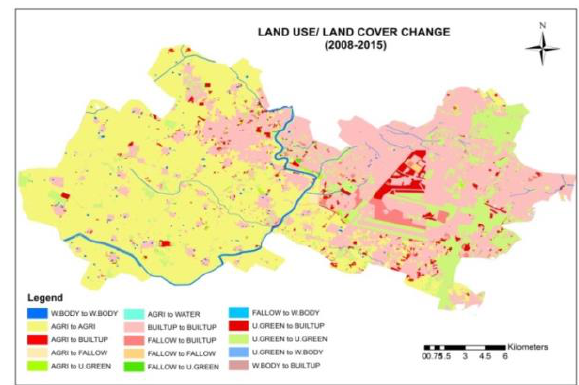
Figure 6: Land Use/Land Cover change map during 2008-2015 for individual classes